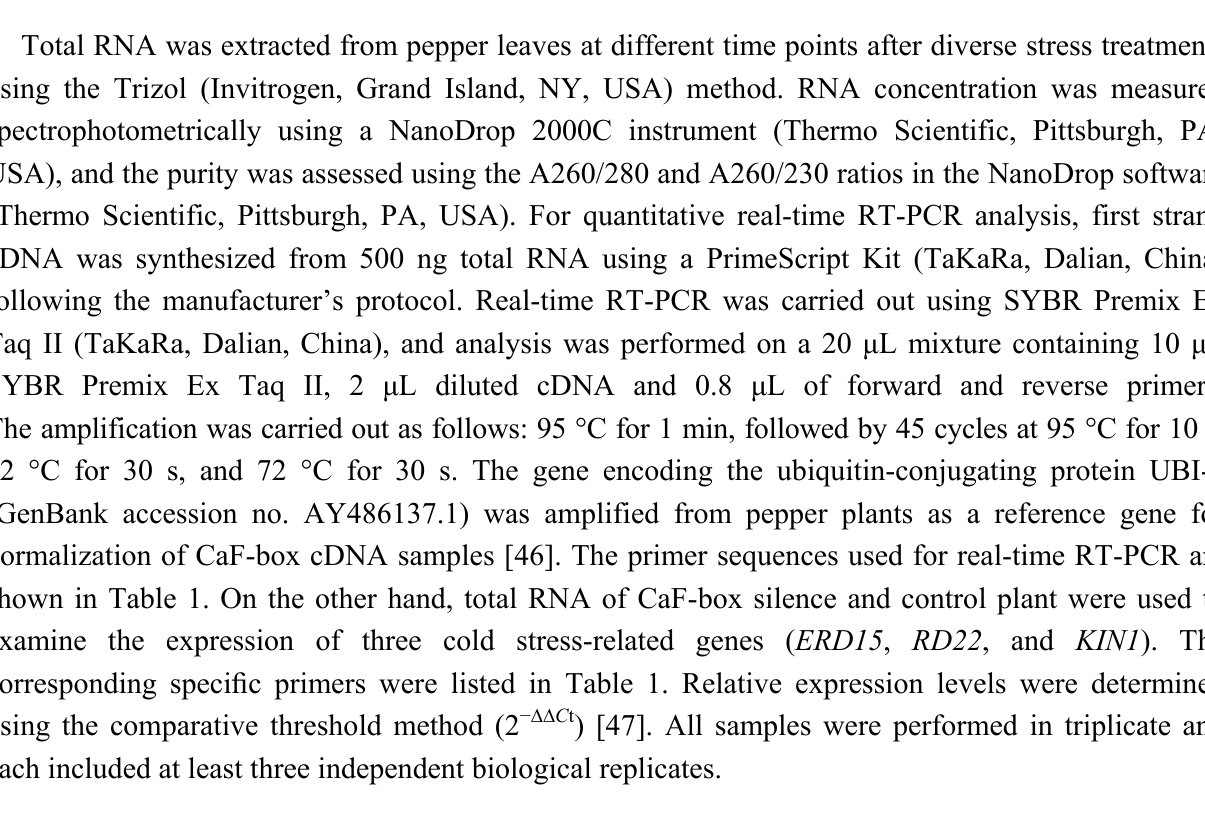
Table 1. Primer sequences used for Real-time RT-PCR